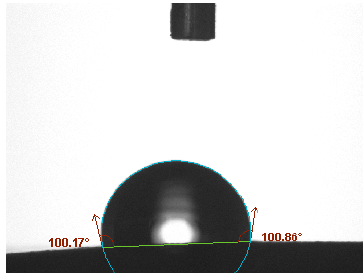
Figure 6. Contact angle in the 40% red mud (RM) mastic. Table 5. Samples that required adhesion improver agent.